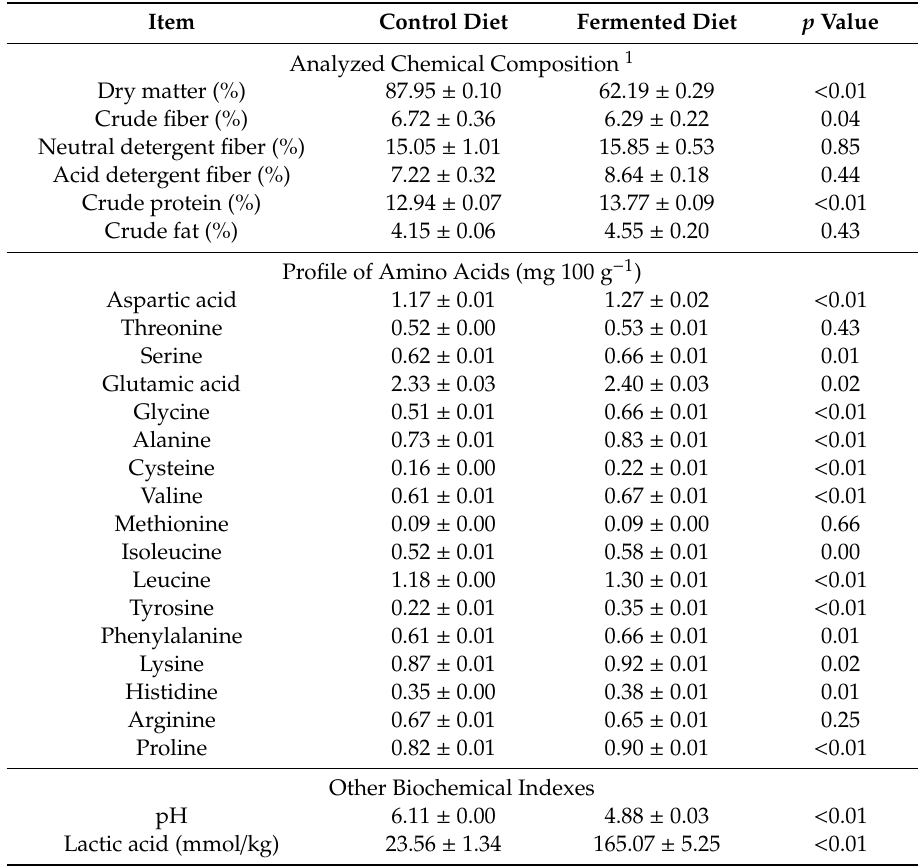
Table 3. Chemical composition and biochemical indexes of experimental diets.